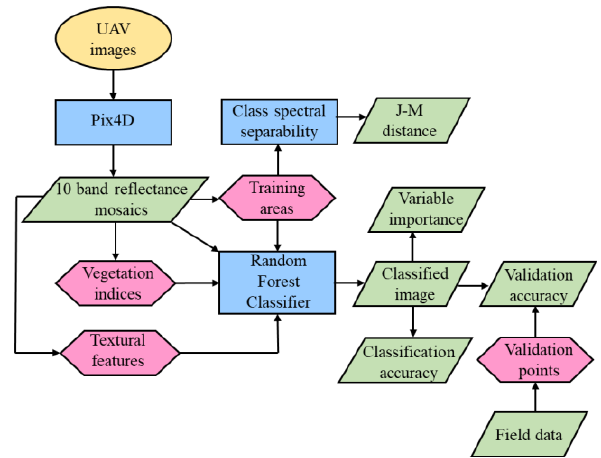
Figure 3 . Flowchart of the method used for processing the UAV images. Table 4. Textural features calculated for each of the ten MicaSense bands (adapted from Haralick et al.,